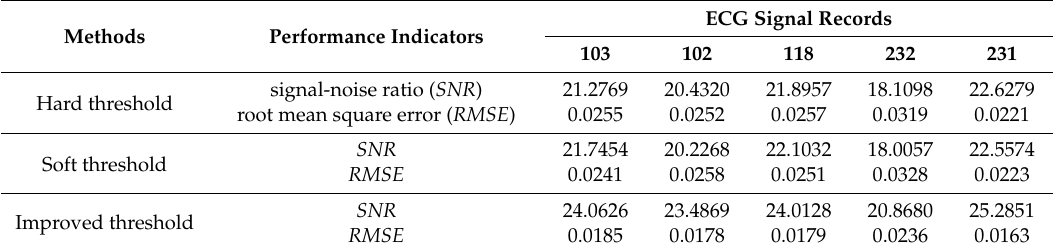
Table 1. Performance indicators of three threshold denoising